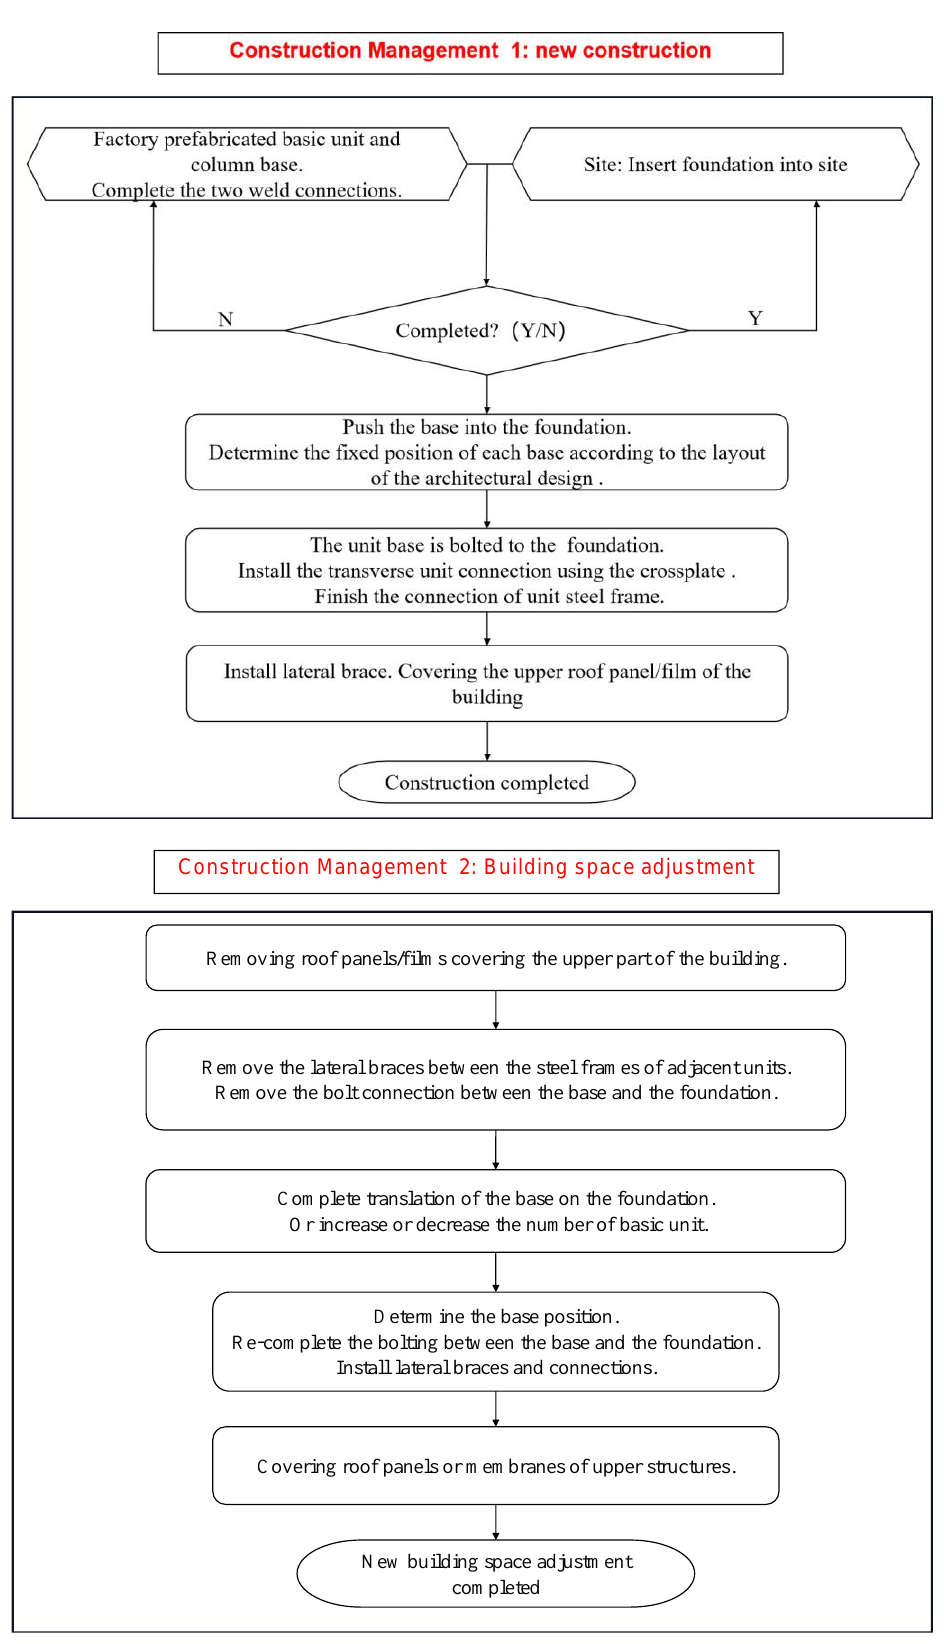
Figure 22. The realization process of the linear extension space building.